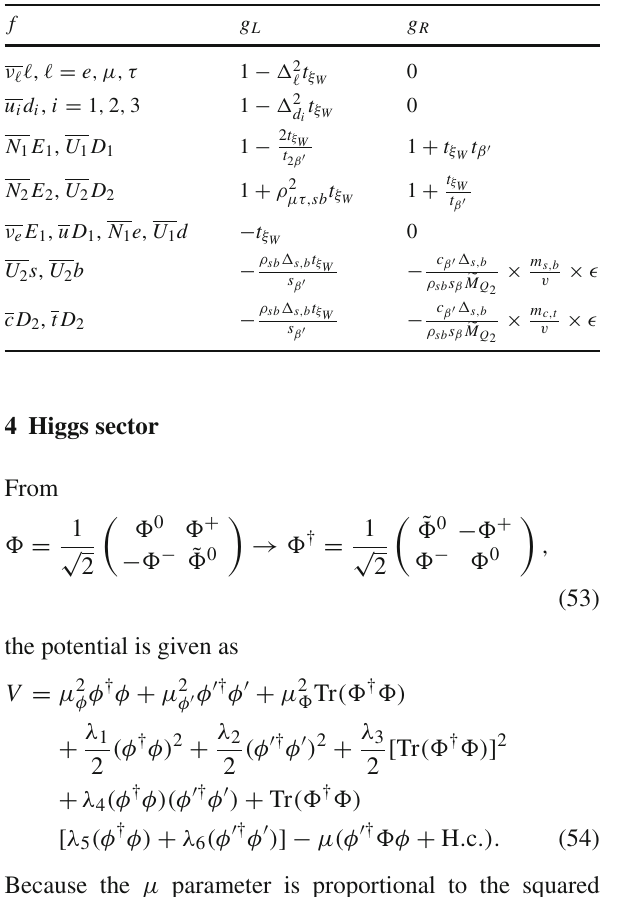
Table 2 Couplings of W boson with